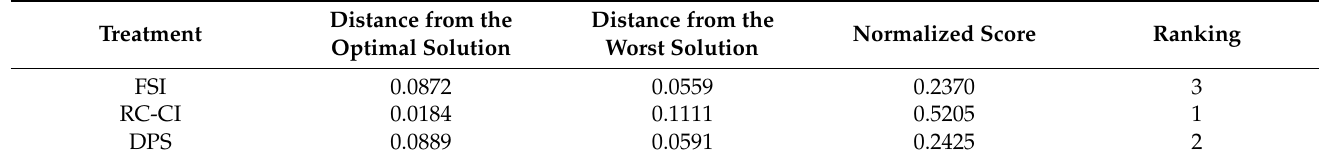
Table 9. Evaluation results of the ENTROPY TOPSIS